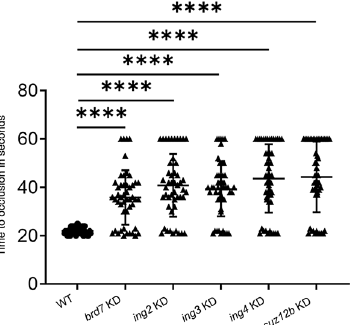
Figure 3. Comparison of time to occlusion of the caudal vein after laser injury between wild-type control 5 dpf larvae and brd7 , ing2 , ing3 , ing4 , and suz12b knockdown larvae by one-way ANOVA. The dot plots represent wild-type larvae (closed circles) and the knockdown larvae (closed triangles). Error bars represent mean ± SD. p-value < 0.05 was considered significant, and 50 larvae each were used in control and knockdown experiments (N = 50). The lines on the top represent a significant difference between wild-type and knockdown samples. **** represents p ≤ 0.0001.